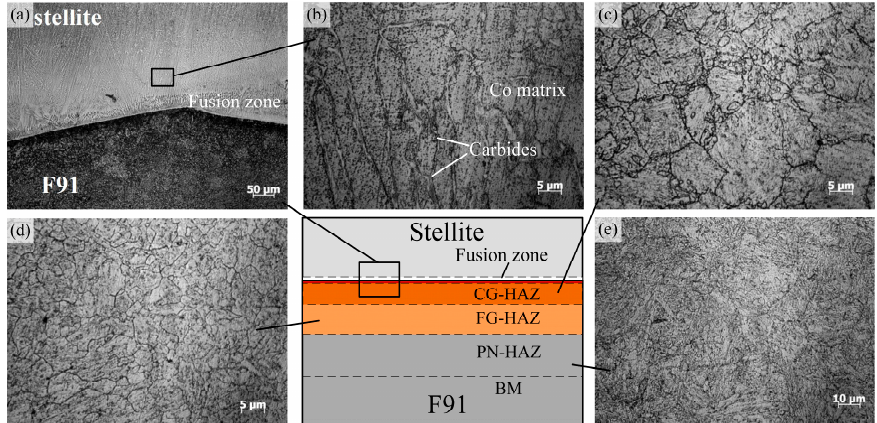
Figure 2. Microstructure of sample #1: ( a ) Stellite-steel interface; ( b ) Stellite coating; ( c )coarse grain heat-affected zone (CG-HAZ); ( d ) fine grain heat-affected zone (FG-HAZ); ( e ) partial normalized zone.